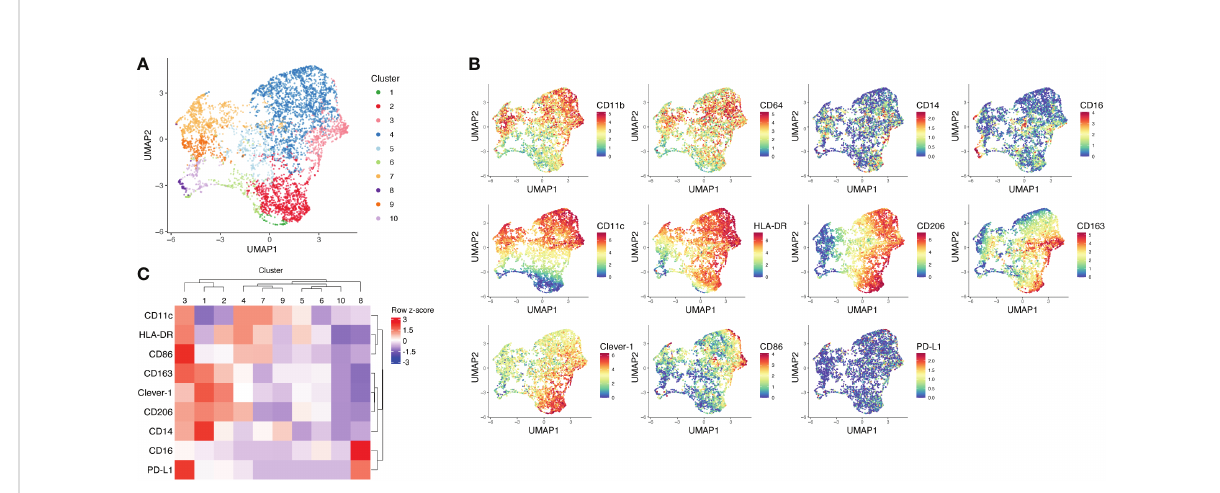
FIGURE 1 Mass cytometry analysis of SVF macrophages of lipedema patients and BMI matched healthy controls. (A) UMAP plot and FlowSOM metaclusters of CD11b + CD64 + myeloid cells (n = 5708) from lipedema patients (n = 5) and healthy controls (n = 5). The SVF samples were pre-gated for viability, singlets and CD45. (B) UMAP plots showing arcsinh-transformed expression values of indicated markers on CD11b + CD64 + cells. (C) Heatmap and unsupervised clustering of FlowSOM metaclusters based on median marker expression in each